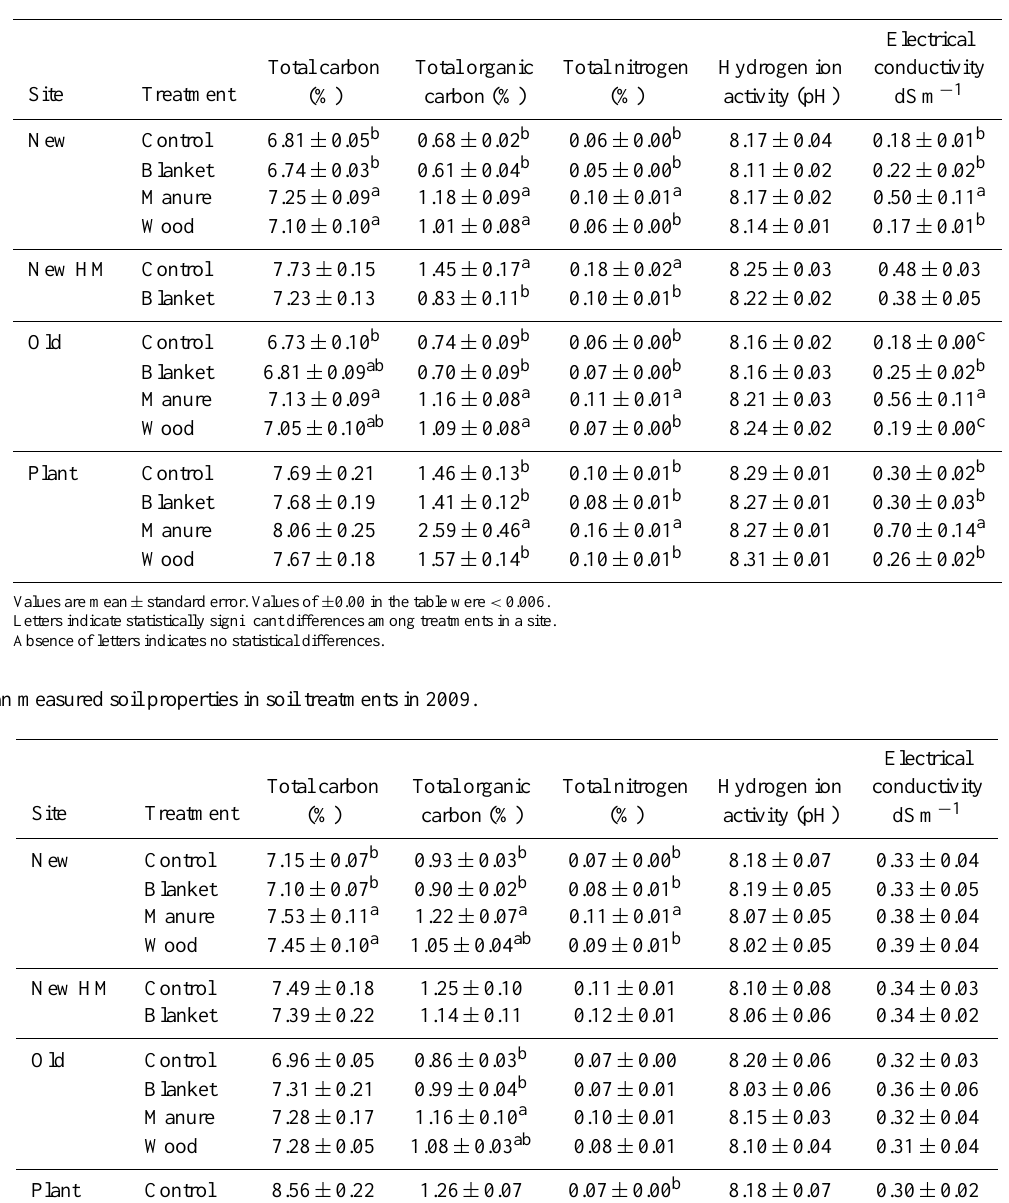
Table 4. Mean measured soil properties in soil treatments in 2008.